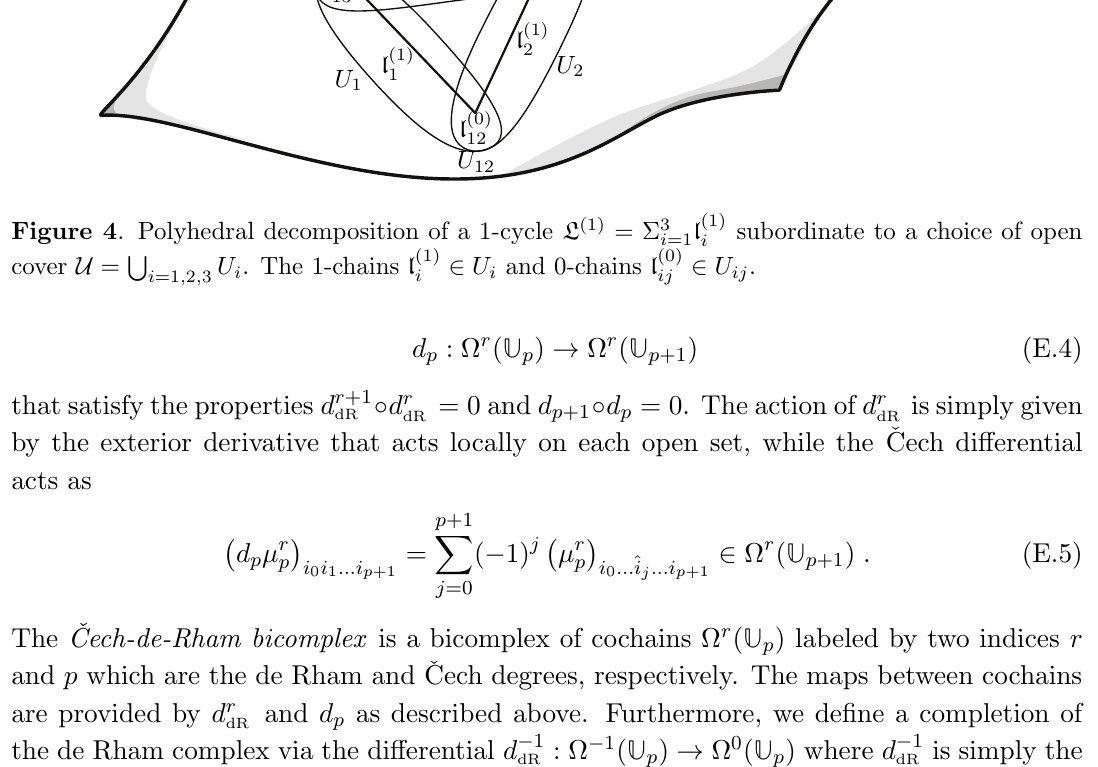
Figure 4 . Polyhedral decomposition of a 1-cycle L (1) = (cid:6) 3